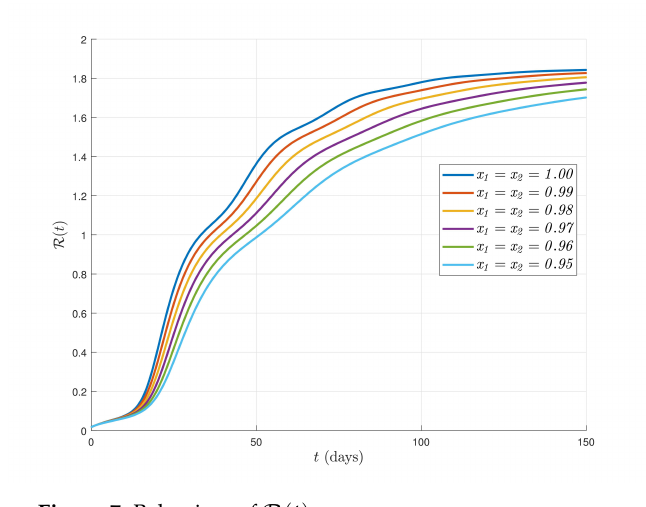
Figure 7. Behaviors of R ( t ) .